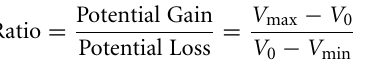
Figure 1 . For the safe option, the participant was guaranteed a payoff of $4. For the risky option, the participant may earn $1 or $10 depending on the action of Player B. Participants were told that since the other players changed on every trial, and only one random trial would be selected for payment,they should treat each trial as independent, and as if it were the only trial presented to them. The side of the screen on which the safe and risky options appeared was randomized across